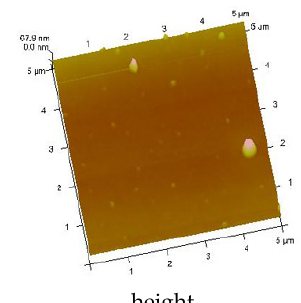
µ m, dip coating before